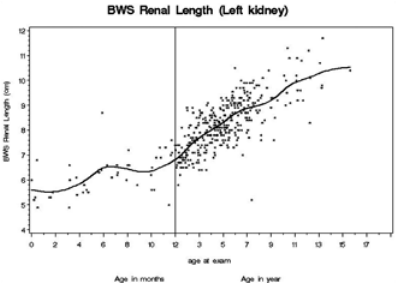
Figure 3 - Renal length and growth of the left kidney in patients with Beckwith-Wiedemann syndrome (BWS)